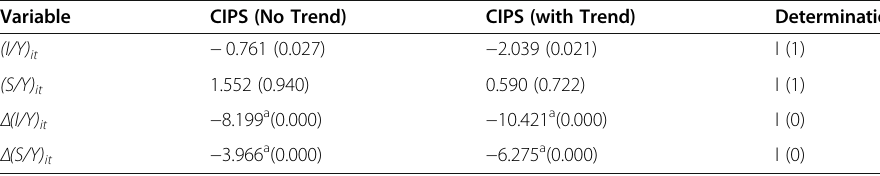
Table 2 Pesaran ’ s panel unit root CIPS (2007) tests